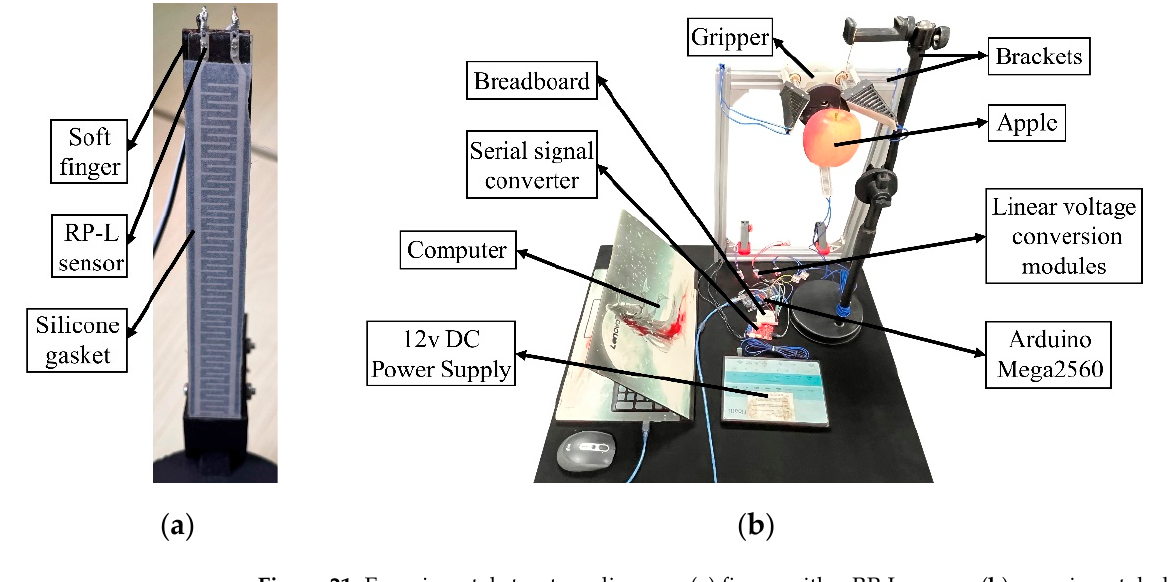
Figure 21. Experimental structure diagram: ( a ) finger with a RP-L sensor; ( b ) experimental platform.